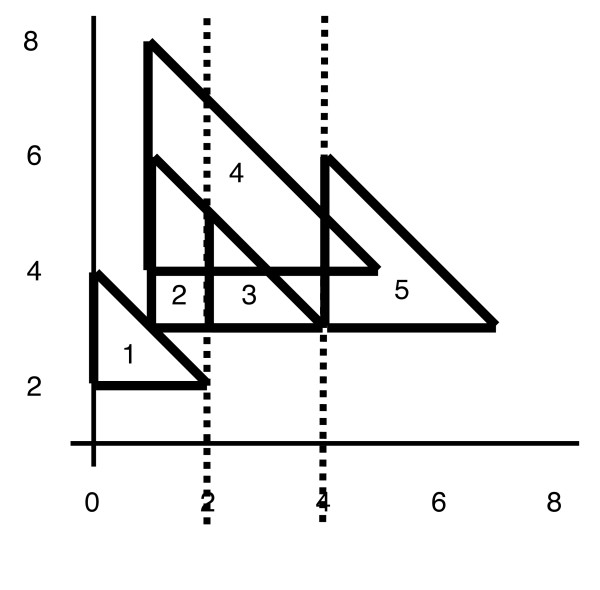
Clique {2, 3,4} at x = 2 has a global ordering of B(2), B(3), B(4), H(2), H(3), H(4) and a global ordering of B(2), B(3), H(2), H(3), B(4), H(4) at x = 4. When an interval is added to the y-structure it can either intersect all of the bases of a clique, or only a part of the bases, and/or all of the hypotenuses, or just a part of them. If it intersects all bases and/or hypotenuses, it can simply be added to that clique, if it only intersects a part of the bases and/or hypotenuses, it will split the clique.